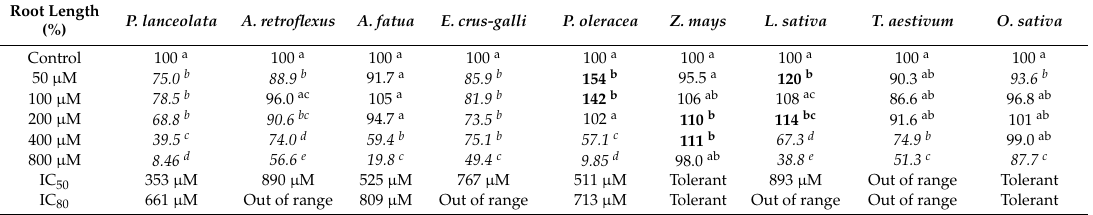
T. aestivum O. sativa